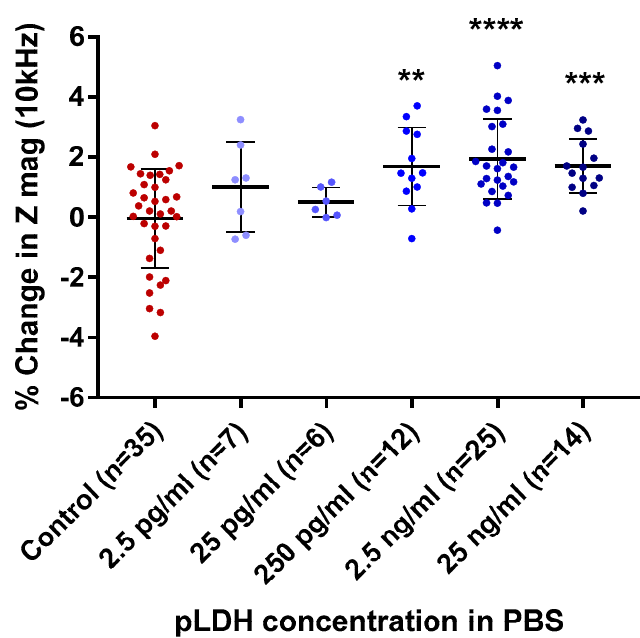
Figure 3. Aggregate data of percentage changes in impedance magnitude (Z mag) with increasing concentrations of pLDH in PBS. Percentage change impedance of with non-spiked PBS (control), 2.5 pg / mL, 25 pg / mL, 250 pg / mL, 2.5 ng / mL, and 25 ng / mL of pLDH, at a measurement frequency of 10 kHz. Error bars are standard deviation, ** p ≤ 0.01, *** p < 0.001, **** p < 0.0001 compared to control